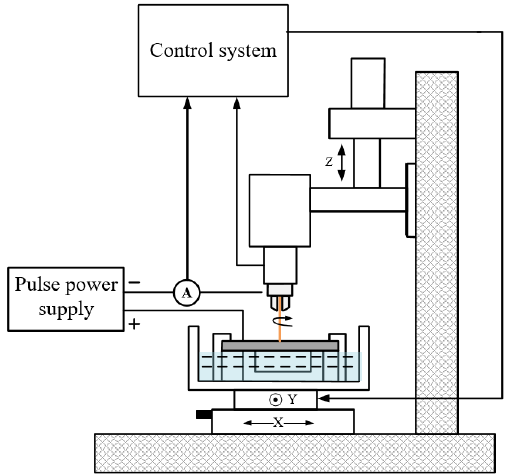
Figure 3. Schematic of experimental system.